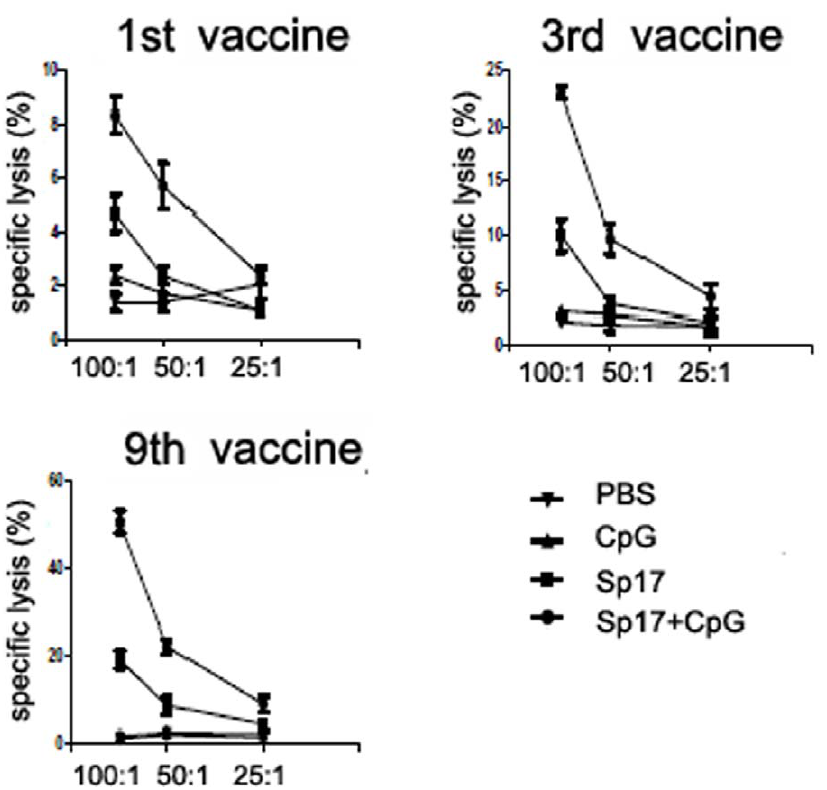
Figure 8. Cytotoxicity assay in the prophylaxis regimen. Splenocytes from the three different formulations of prophylactically vaccinated mice and controls were collected and analyzed by 51 Chromium-release assay on days 7 (first vaccine), 97 (third vaccine) and 270 (ninth vaccine), using splenocytes as effector cells and ID8 as target cells. These results were obtained from three independent experiments. X axis indicate effector:target ratios.